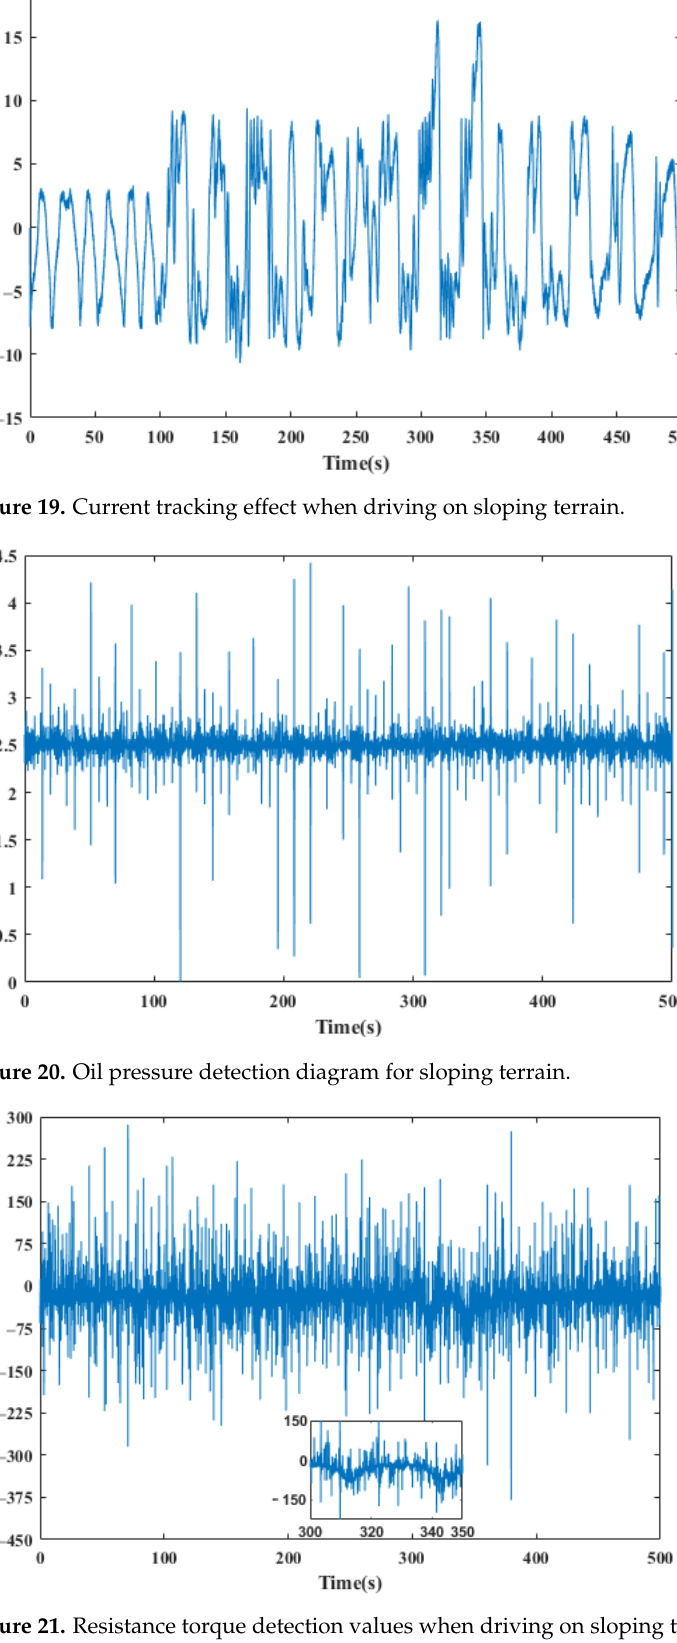
Figure 21. Resistance torque detection values when driving on sloping terrain.